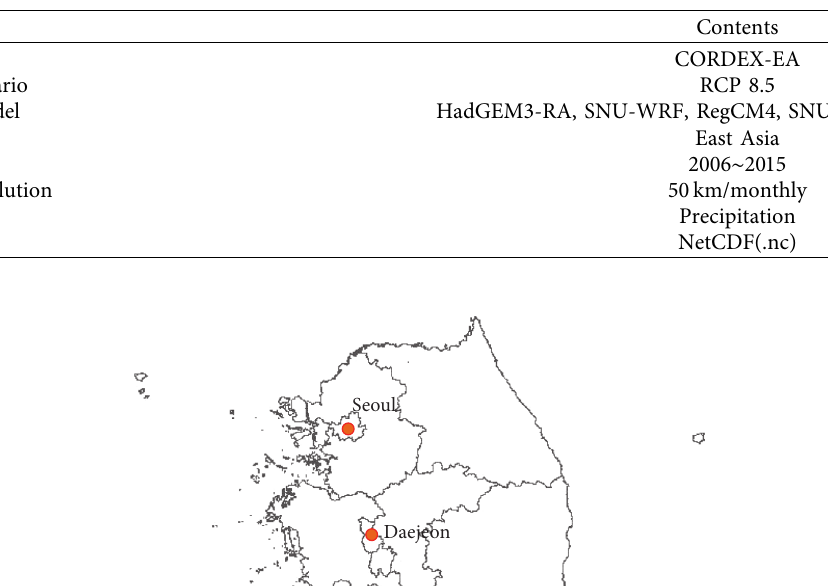
Table 1: Data collection from RCM [49].